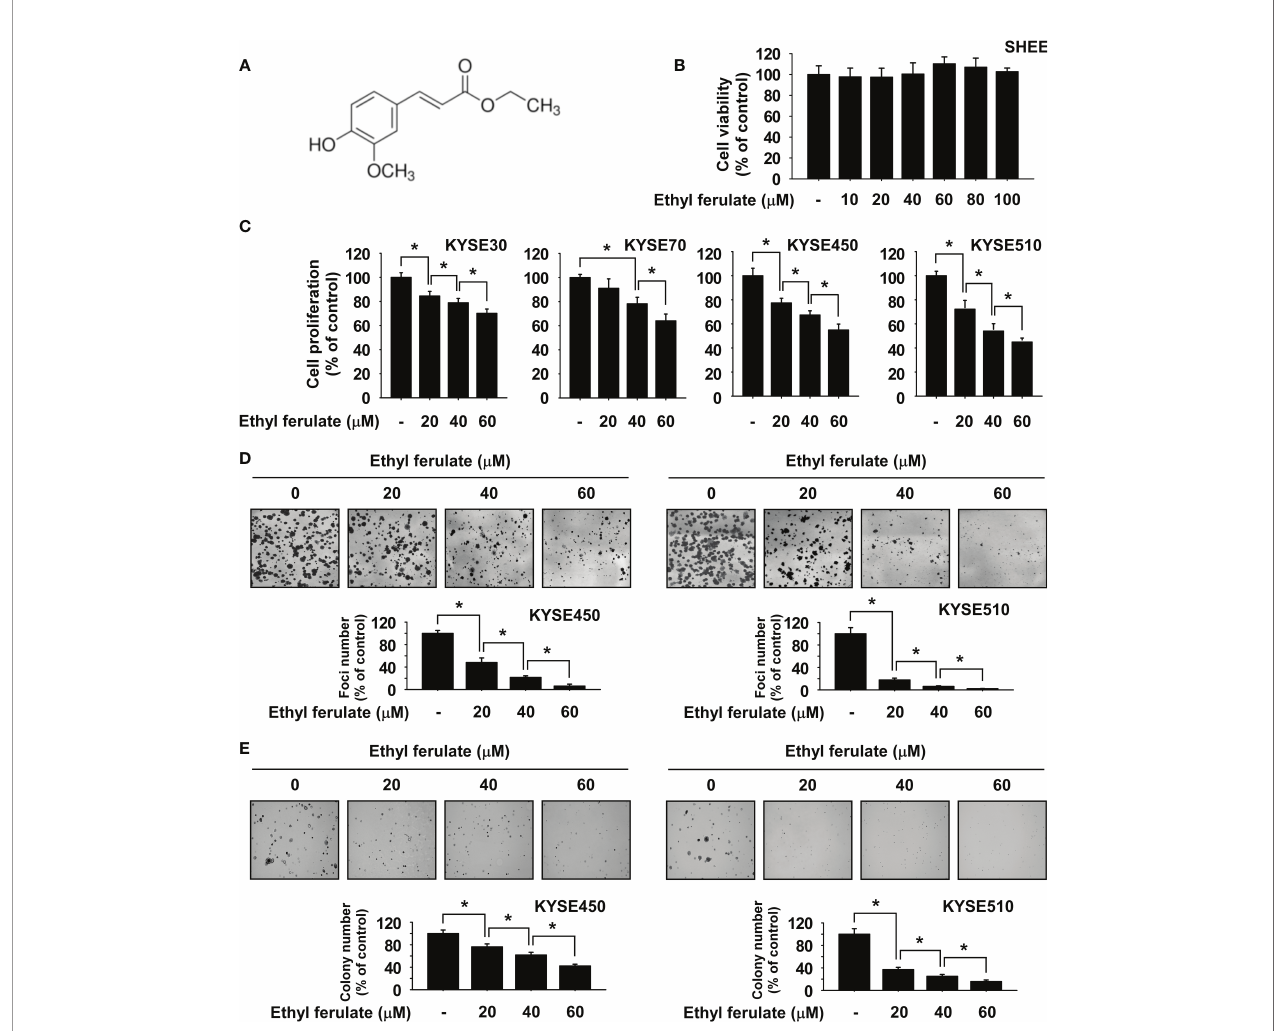
FIGURE 1 | Ethyl ferulate inhibits esophageal squamous cell carcinoma (ESCC) cell growth. (A) Chemical structure of ethyl ferulate. (B) The cytotoxicity of ethyl ferulate was determined using SHEE normal esophageal cells. Cell growth was determined by MTT assay. (C) Effect on the growth of ESCC cells by ethyl ferulate treatment. Cell growth was determined by MTT assay. (D) Effect on focus formation upon treatment with ethyl ferulate. Focus ability was determined by the focus formation assay. (E) Effect on anchorage-independent ESCC cell growth upon treatment with ethyl ferulate. Colonies were imaged using a microscope and quanti fi ed with the Image-Pro PLUS (v.6) computer software program. For panels (B – E) , data are shown as means ± SD of values from 3 independent experiments each with triplicate samples. The asterisk (*) indicates a signi fi cant ( P < 0.05) inhibitory effect of ethyl